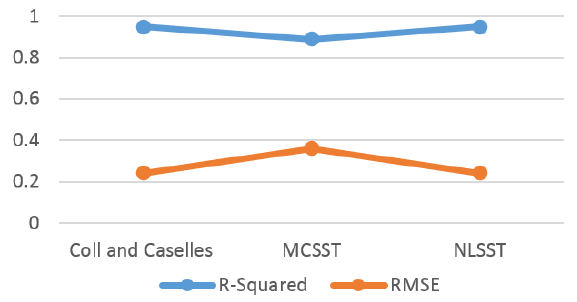
Figure 7. Comparison between RMSE and